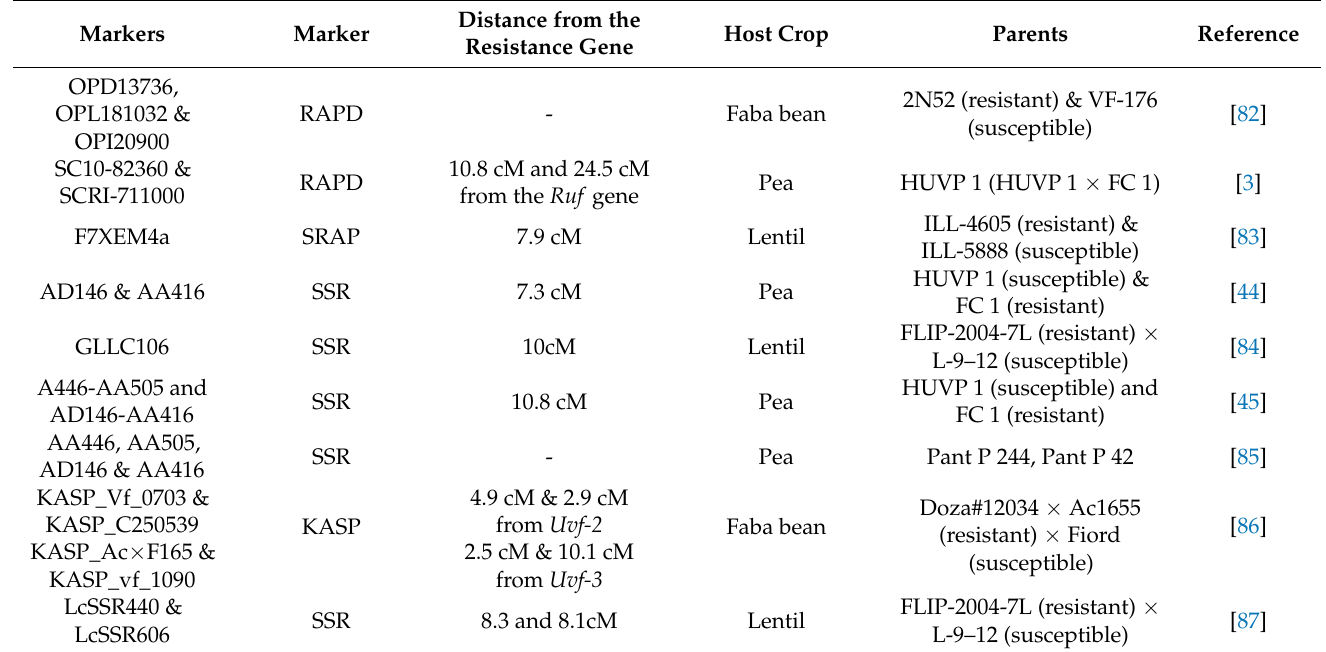
Table 2. Molecular markers associated with rust ( Uromyces vicia - fabae Pers.) resistance genes in three hosts (Pea, Lentil, and Faba